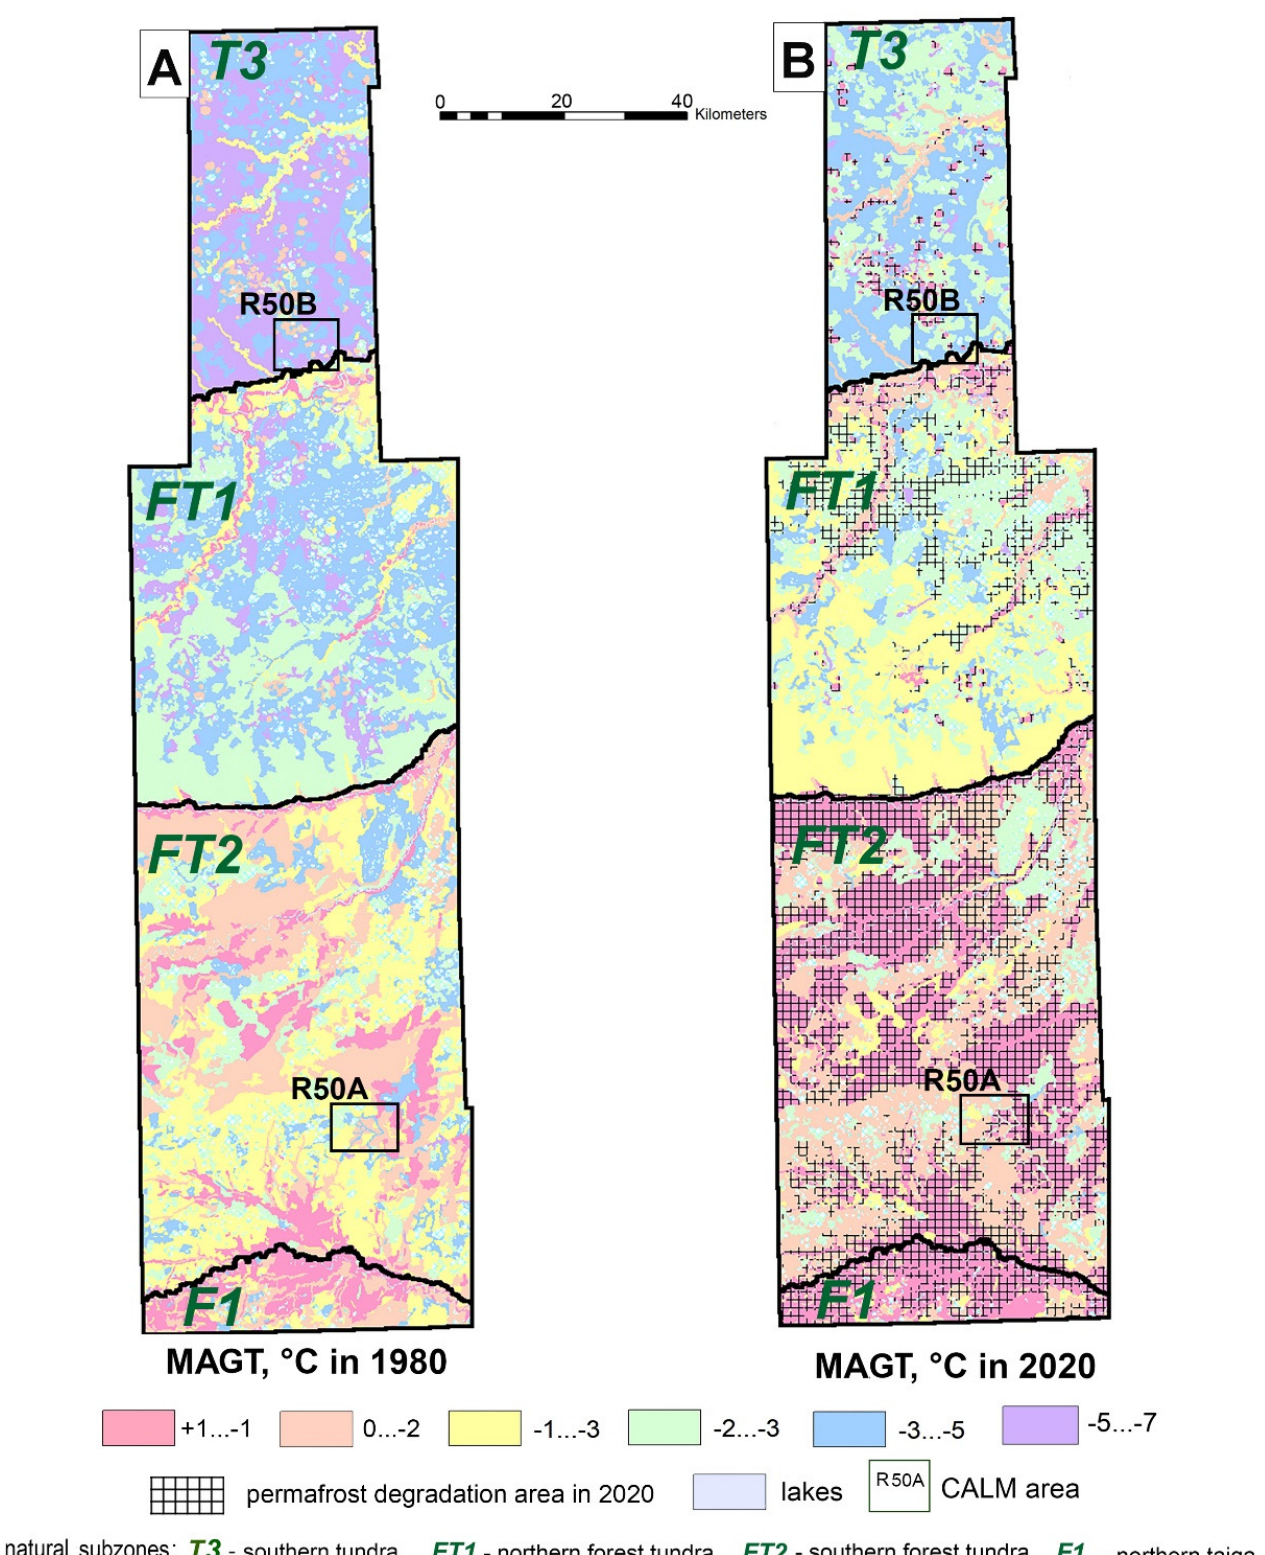
Figure 9. Changes in the mean annual ground temperatures for two time intervals: ( A ) the 1980s, and ( B ) the modern period, 2020. North of Western Siberia, the territory of the Urengoy field, transect from northern taiga to southern tundra.